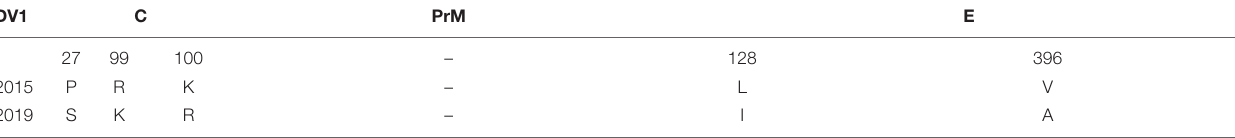
TABLE 4 | The amino acid sequences of DENV-1, DENV-2 and DENV-3 structural proteins (C/prM/E) were compared by BioEdit, and the protein structure was predicted by SWISS-MODEL (expasy.org).